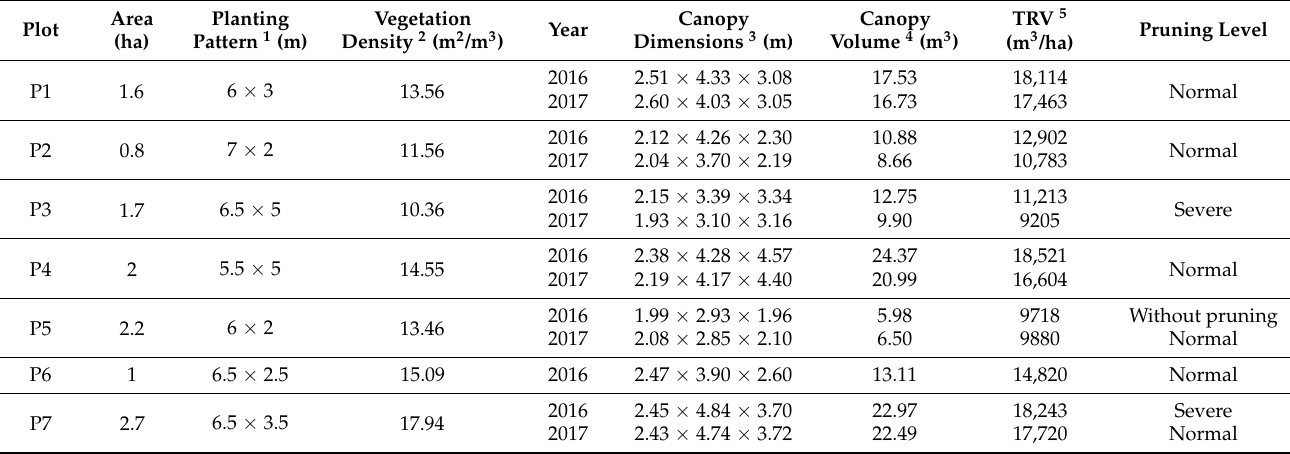
1 Row spacing × tree spacing. 2 Area of leaves per unit of canopy volume calculated considering the two sides of the leaves and following the methodology of Fonte et al. [28]. 3 Canopy height × diameter across the row × diameter along the row, measured with the methodology indicated in Fonte et al. [28]. 4 Calculated considering citrus canopy as an ellipsoid according to the equation: canopy volume (m 3 ) = π /6 × canopy height (m) × diameter across the row (m) × diameter along the row (m). 5 Tree Row Volume, calculated with the equation: TRV (m 3 /ha) = canopy height (m) × diameter of the canopy across the row (m) × 10,000/row spacing